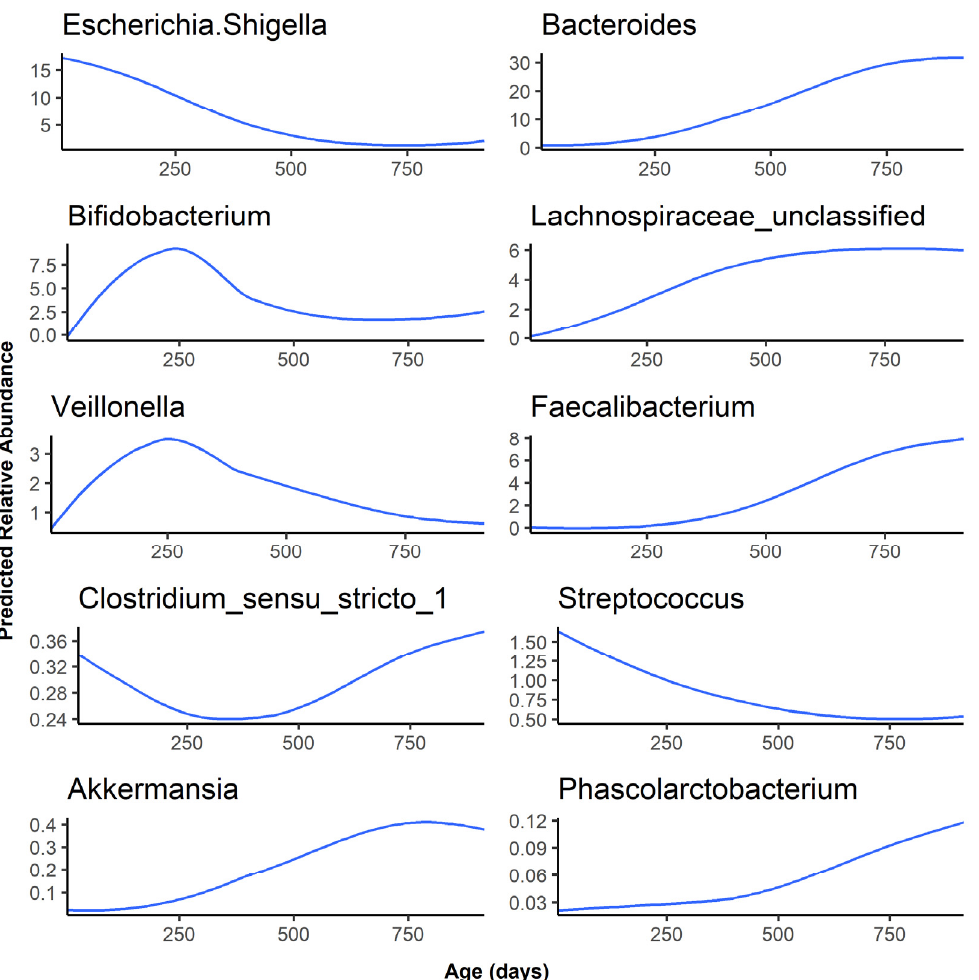
Figure 2. Predicted abundance over time for the top 10 most abundant genera. The predicted relative abundance of each taxon is shown as a function of infant age.